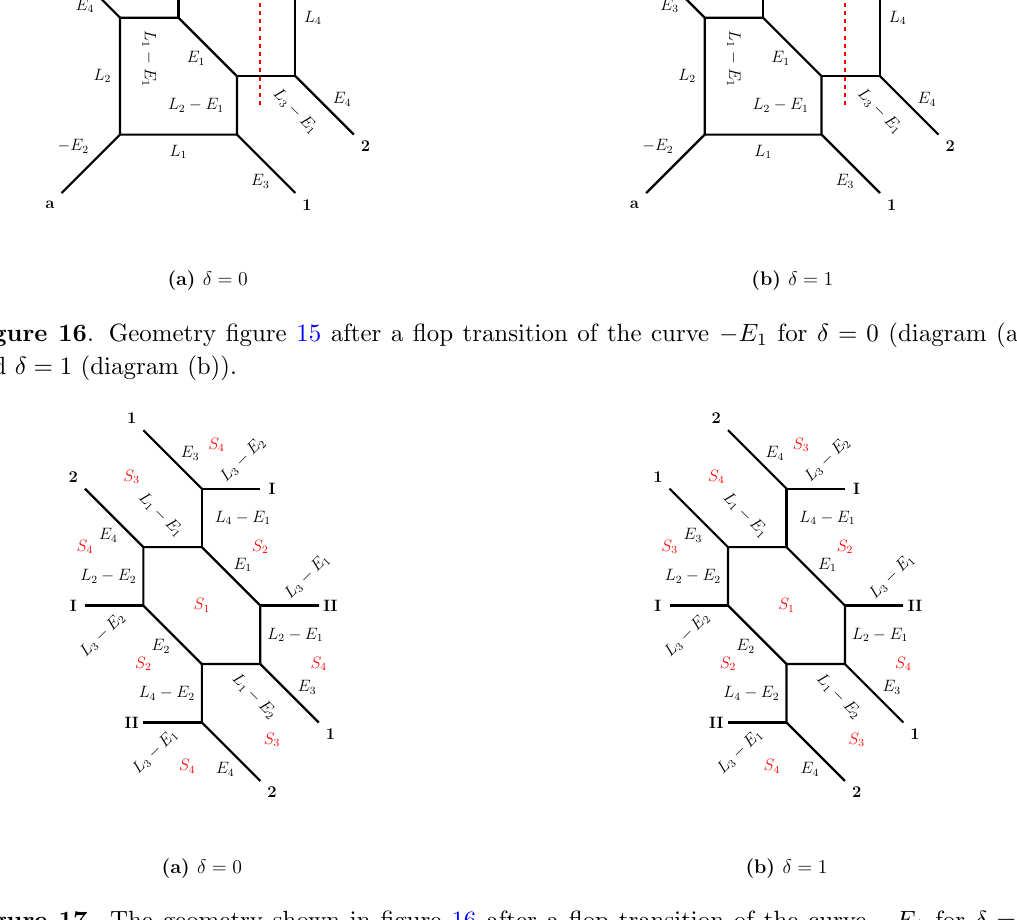
Figure 17 . The geometry shown in (cid:12)gure 16 after a (cid:13)op transition of the curve (cid:0) E 1 for (cid:14) = 0 (diagram (a)) and (cid:14) = 1 (diagram (b)). The curves S 1 ; 2 ; 3 ; 4 are explained in the text.